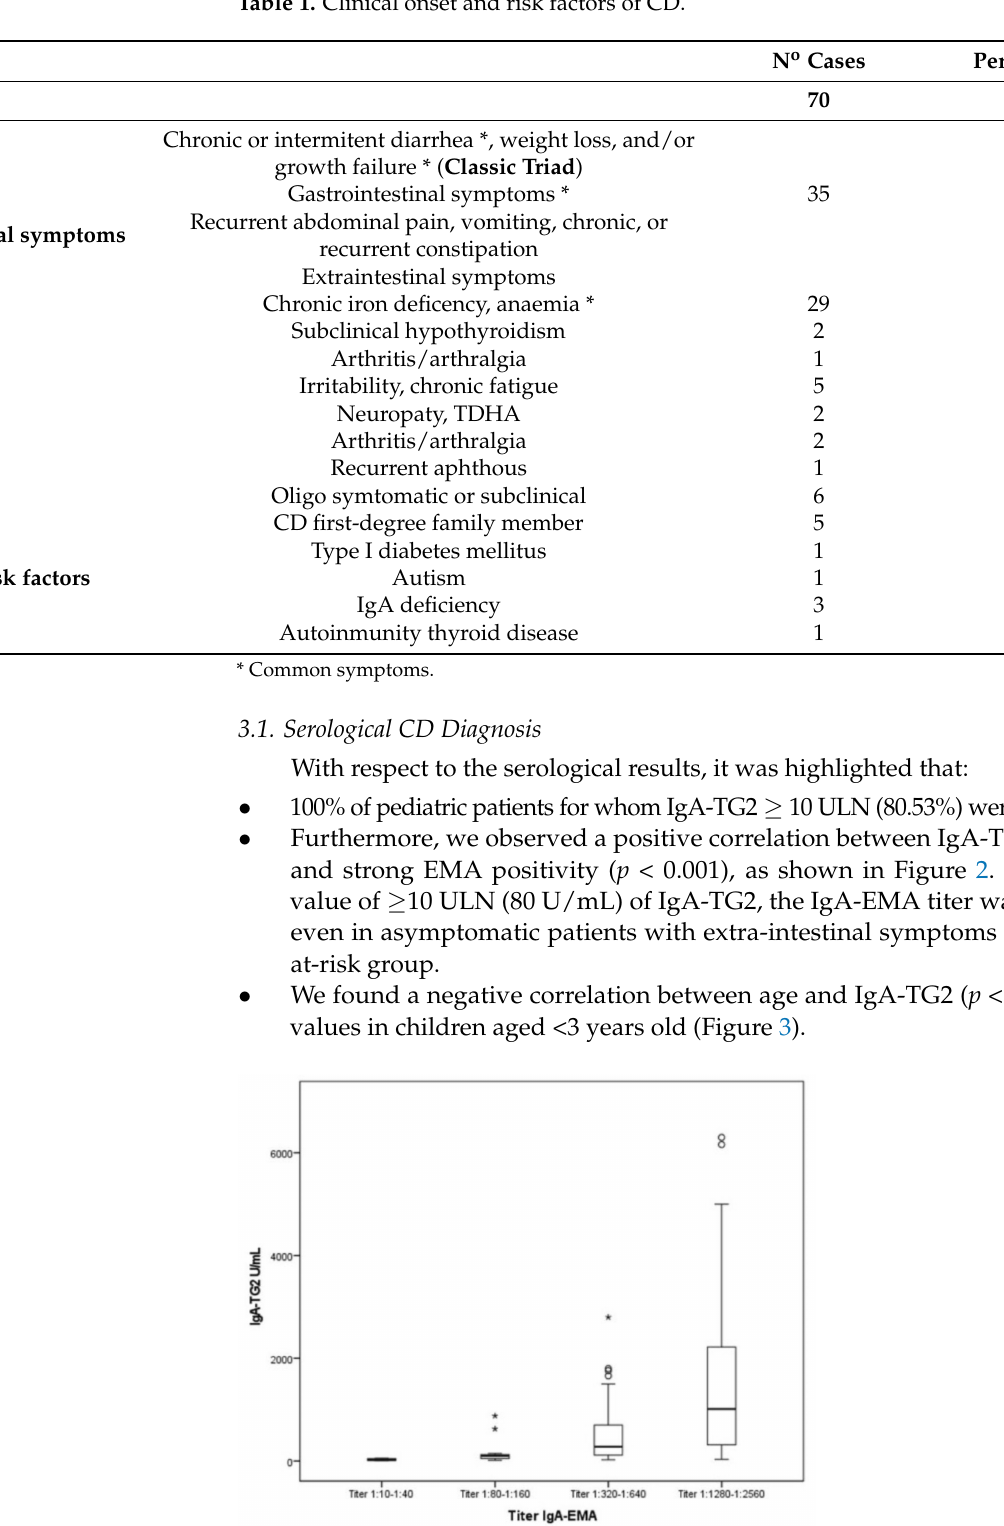
Table 1. Clinical onset and risk factors of CD.